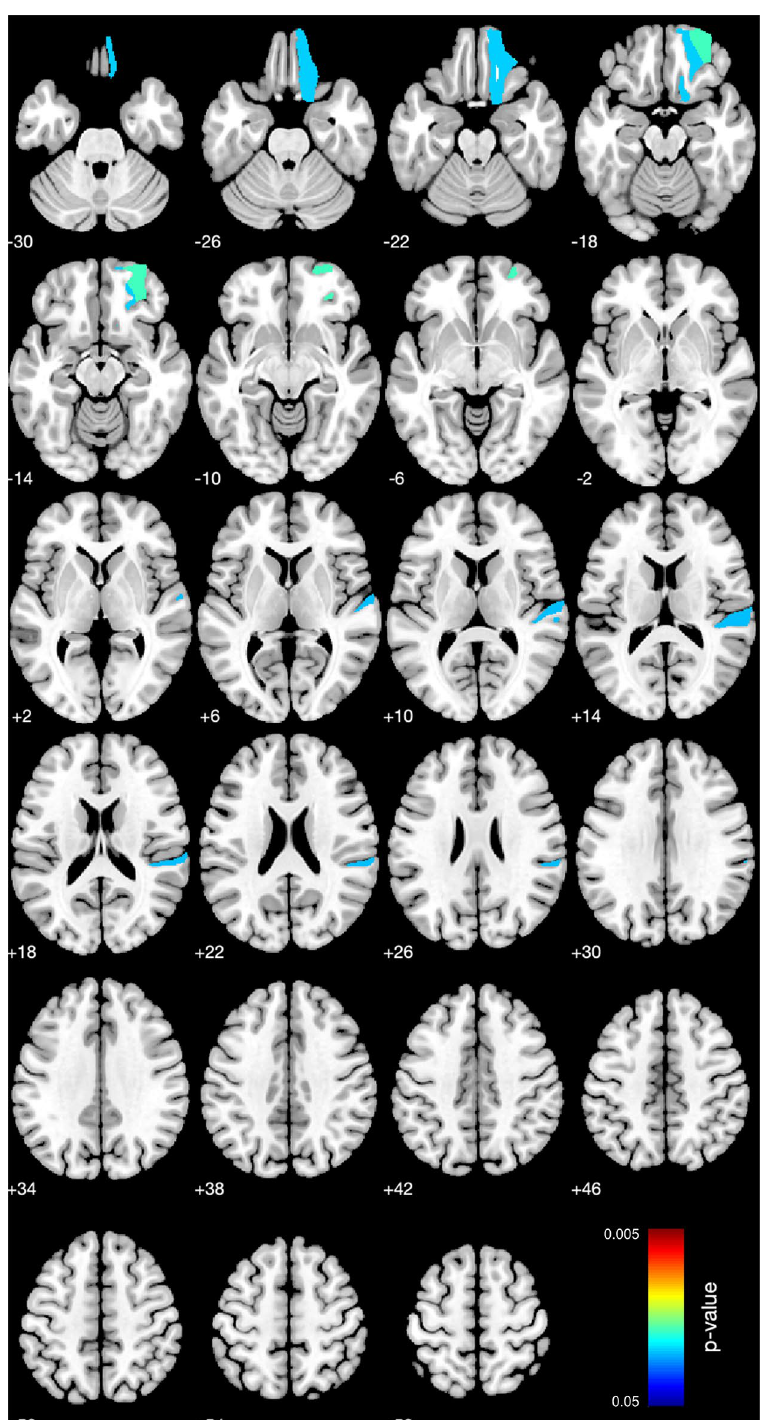
Figure 3. The statistical map for the whole-brain analysis in GM volume (difference between ASD and TD groups of children, Holm-Bonferroni corrected p < 0.05); neurological